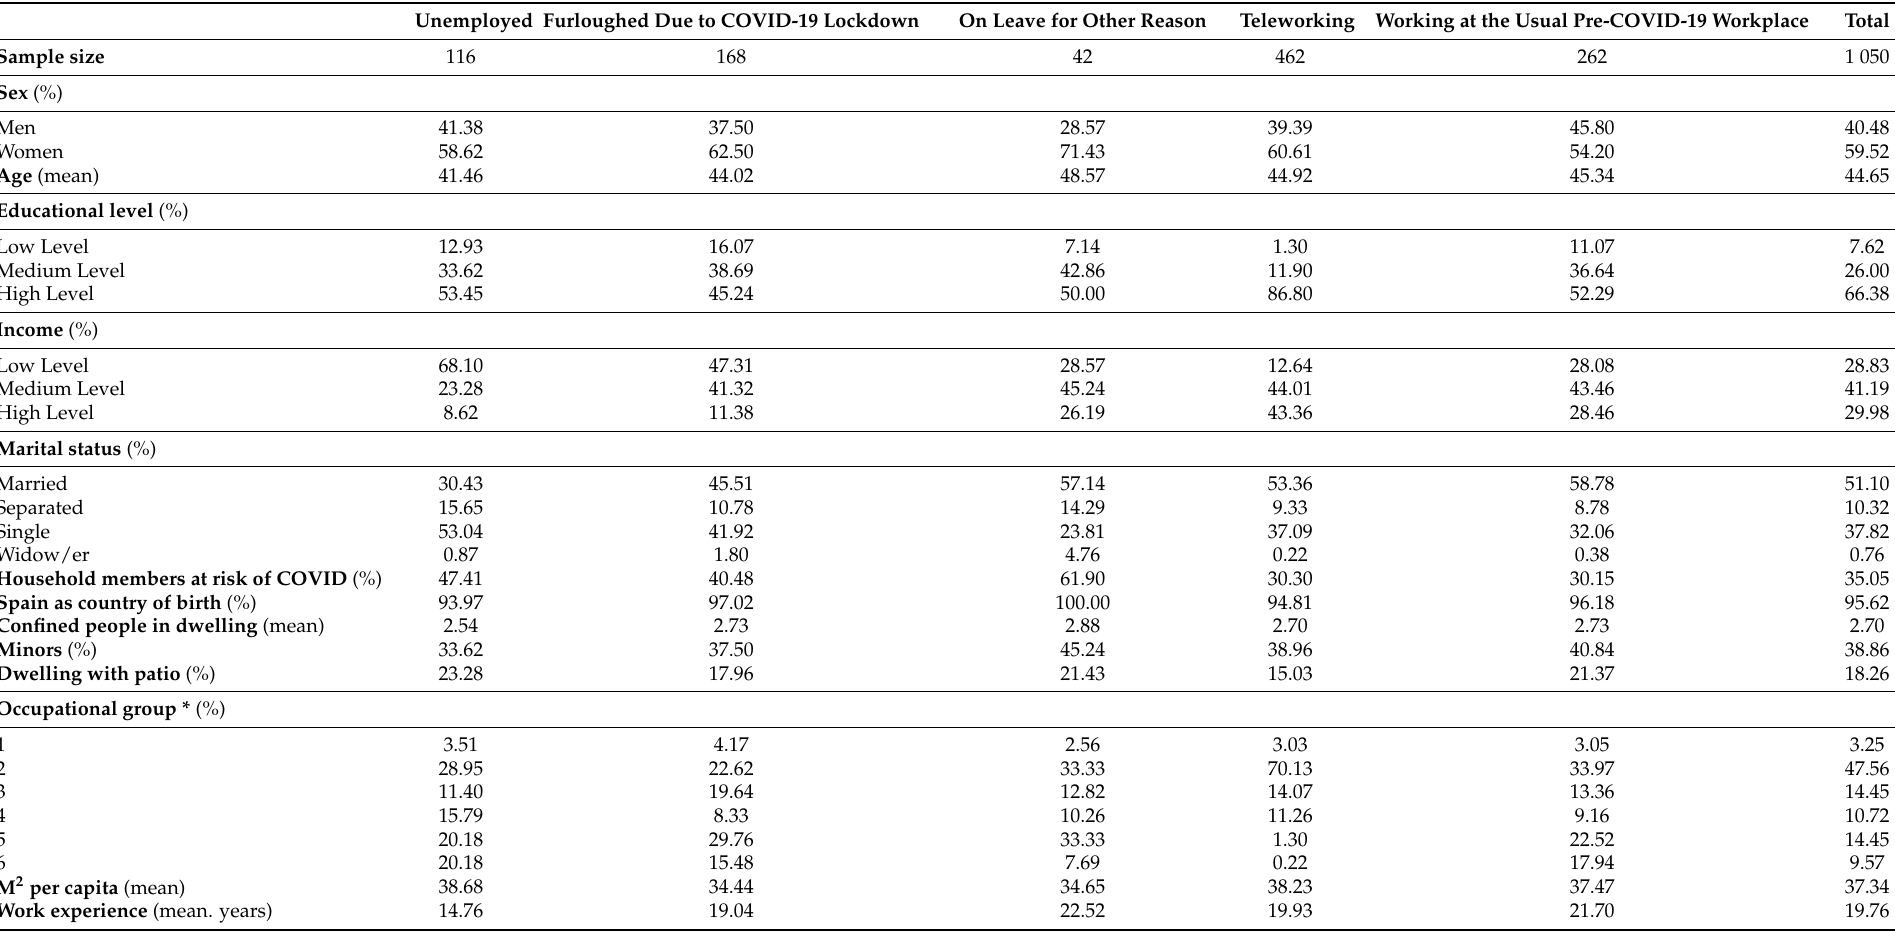
Table 2. Distribution of variables depending on work-related